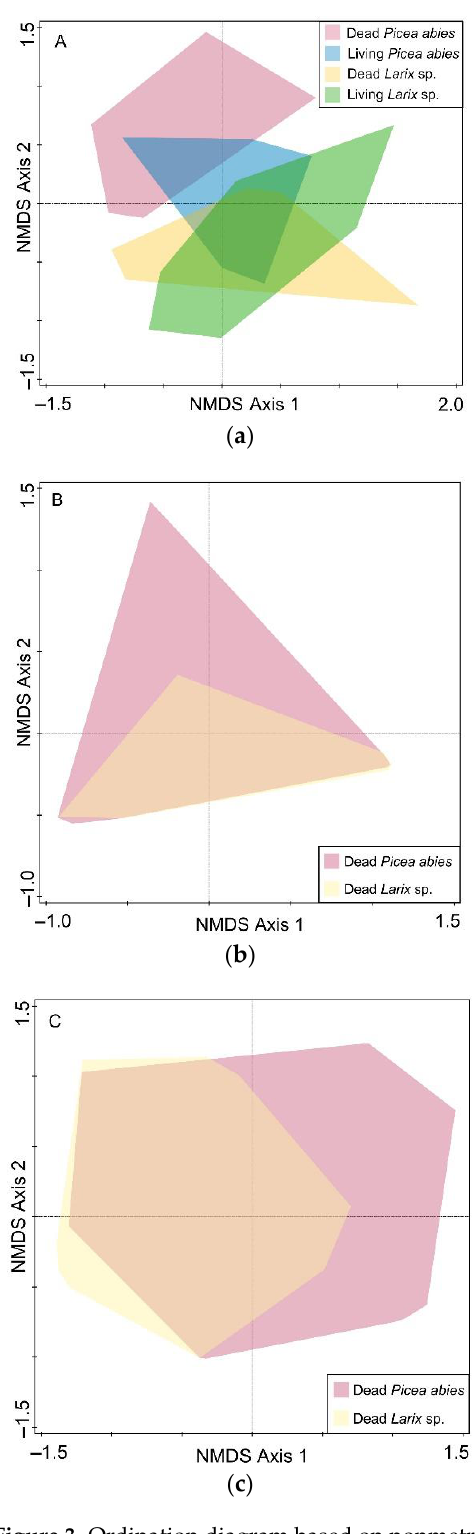
Figure 3. Ordination diagram based on nonmetric multidimensional scaling of insect communities detected in association with Picea abies and Larix sp. trees. Insects were assessed using: ( a ) sticky traps attached to the surface of dead and living trees (47.1% variation explained on axis 1 and 31.9% explained on axis2, ( b ) bark sheets removed from dead trees (52.7% on axis 1 and 31.8% on axis 2), and ( c ) insect exit holes recorded on dead trees (47.2% on axis 1 and 28.5% on axis 2).